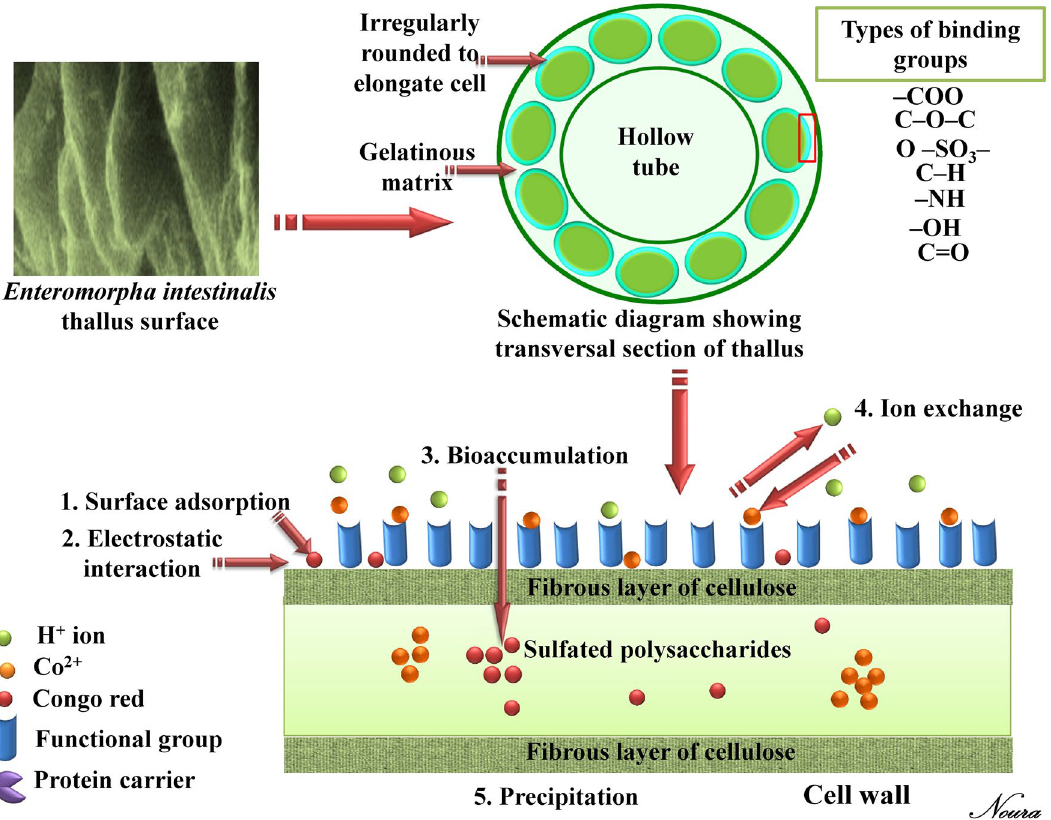
Figure 9. Schematic diagram showing the possible kinetic mechanisms of metal ions biosorption by Enteromorpha intestinalis thallus surface. The photograph is a part of scanning electron microscope for Enteromorpha intestinalis thallus